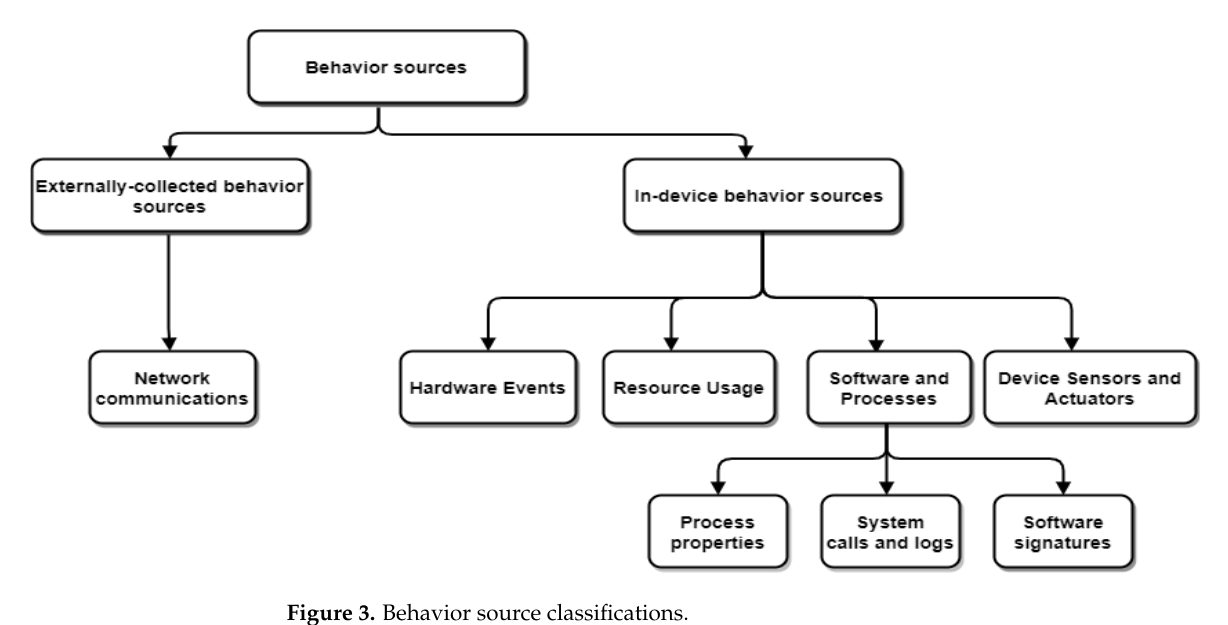
Figure 3. Behavior source